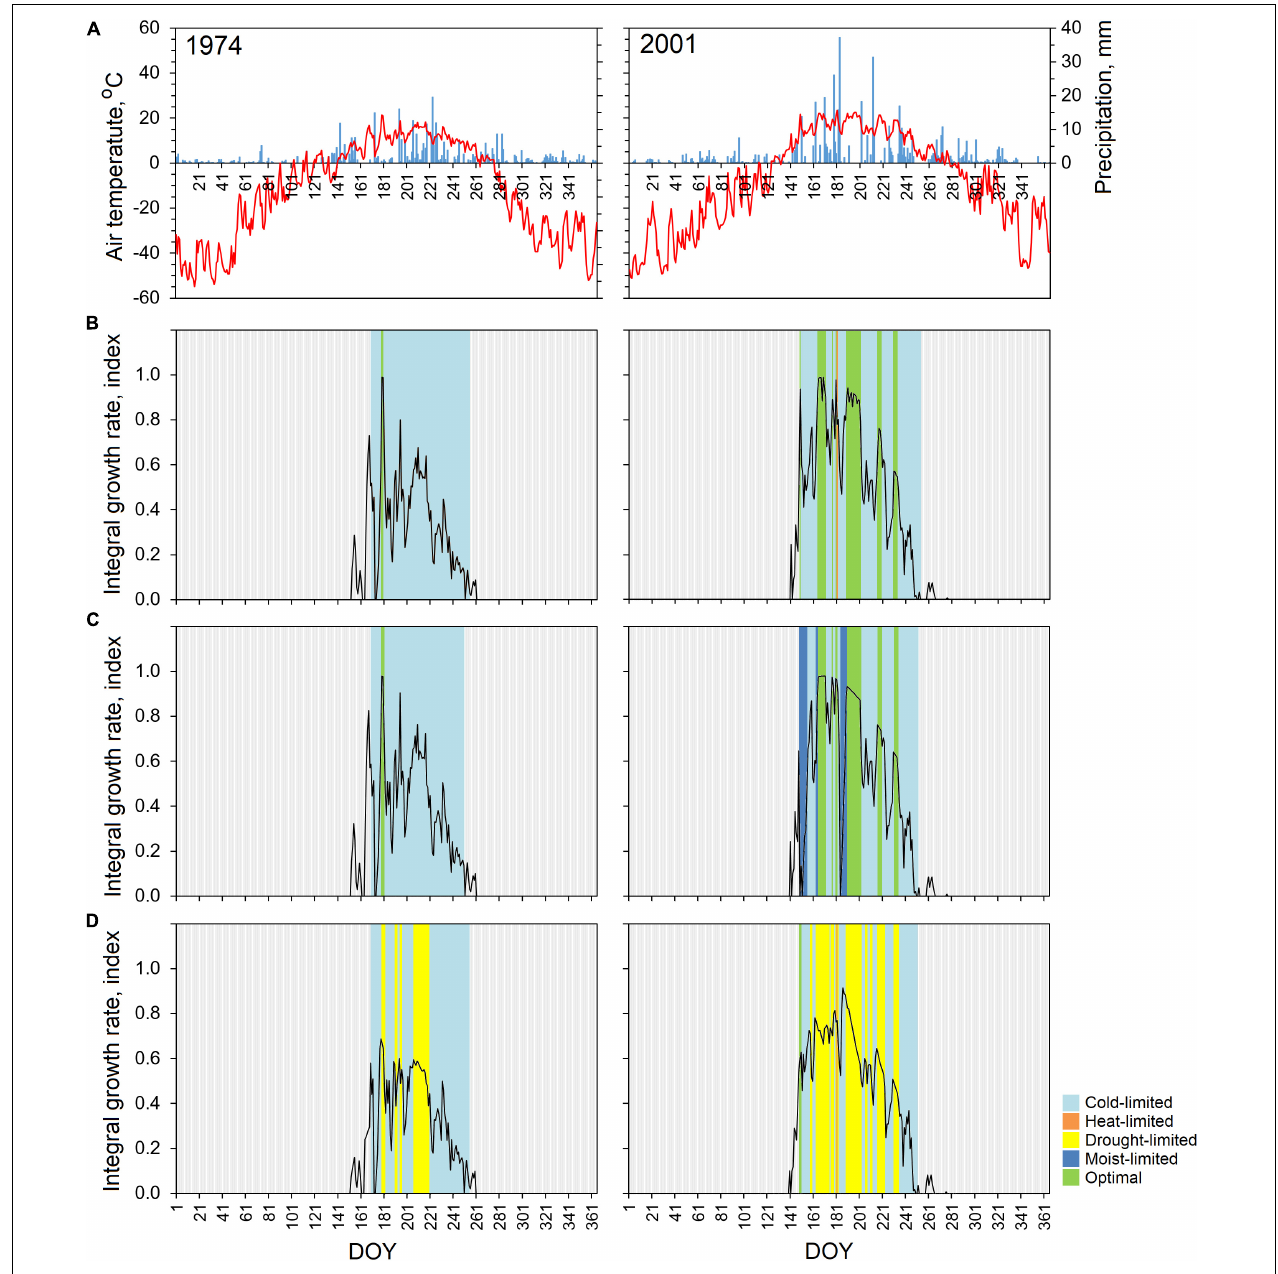
FIGURE 4 | Daily air temperature (red line) and amount of precipitation (blue column) during 1974 and 2001 (A) , and daily integral growth rate of Betula pubescens : (B) PL, (C) TT, and (D) OS. Colors depict the driving climatic